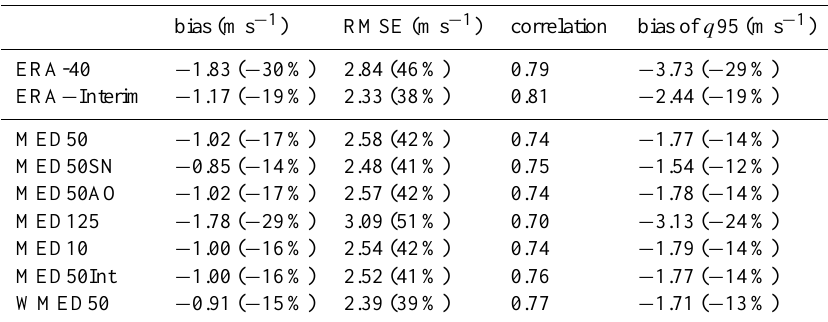
Table 3. Mean values over 2000–2001 and over the Western Basin for the bias, the RMSE, the temporal correlation and the 95th percentile bias of the daily wind speed compared with QuikSCAT for ERA-40, ERA-Interim and each ALADIN-Climate simulation. Percentages indicate the ratio relative to QuikSCAT mean value (for bias and RMSE) and q 95 value (for q 95